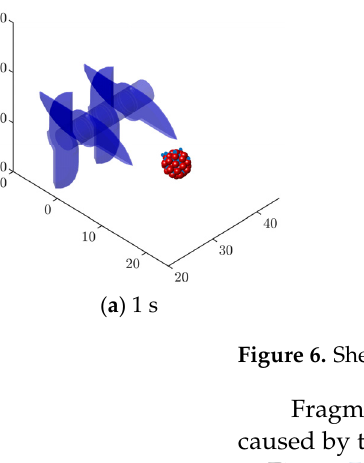
tween 1.3 and 1.4 s. As the impeller moves the other gray particles inward, it forces the due to the extrusion of the other particles. In Figure 7b, blue and red arrows represent the directions of the blue and red particle cluster velocities, respectively. As observed in Figure 7c, by 1.5 s, there seemed to be a split between the blue and red particle clusters. The powder particles were repeatedly crushed in the particle flow, leading to a steady particle size reduction.